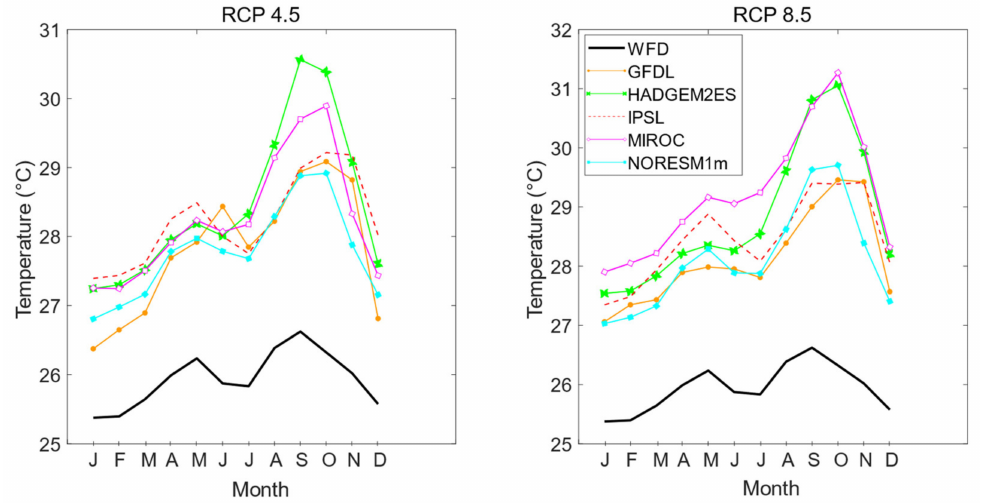
Figure 5. Mean monthly temperature ( ◦ C) in the IRB for the WFD, each GCM, and both RCP